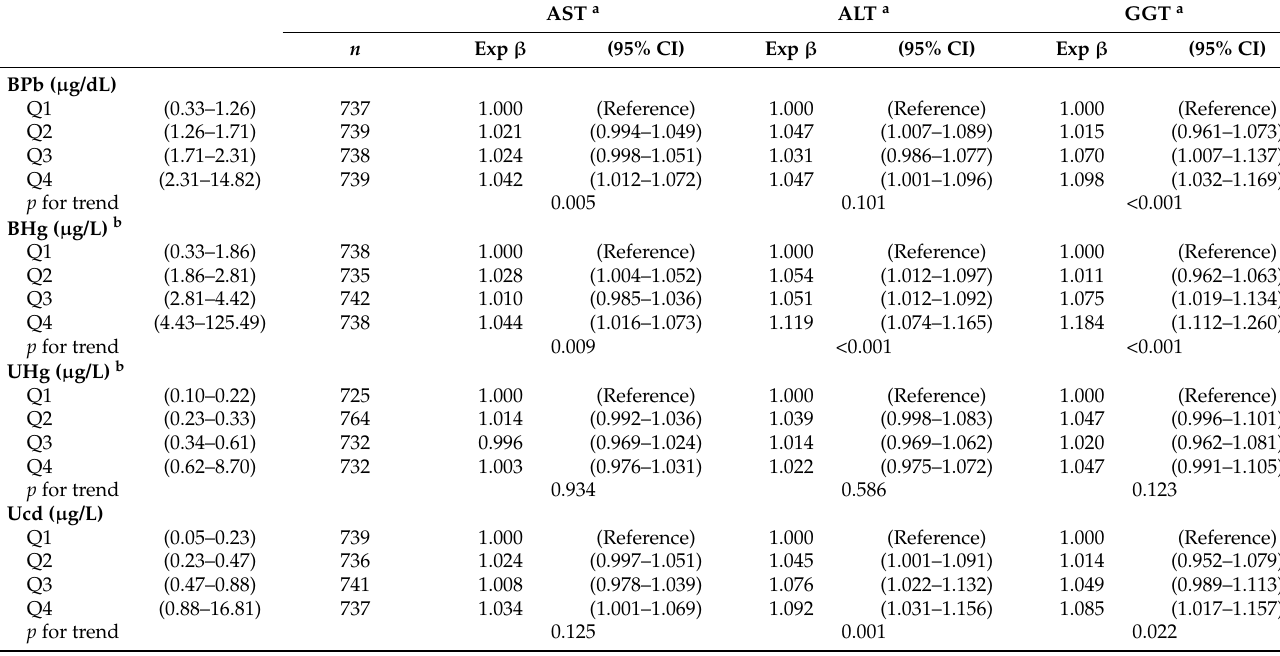
Table 3. Adjusted proportional changes (95% CI) between heavy metals and liver function biomarkers ( n =